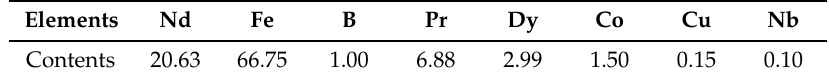
Figure 1. Microstructure of a NdFeB permanent magnet. Table 1. Chemical compositions of the sintered NdFeB permanent magnet N48H (wt %). Elements